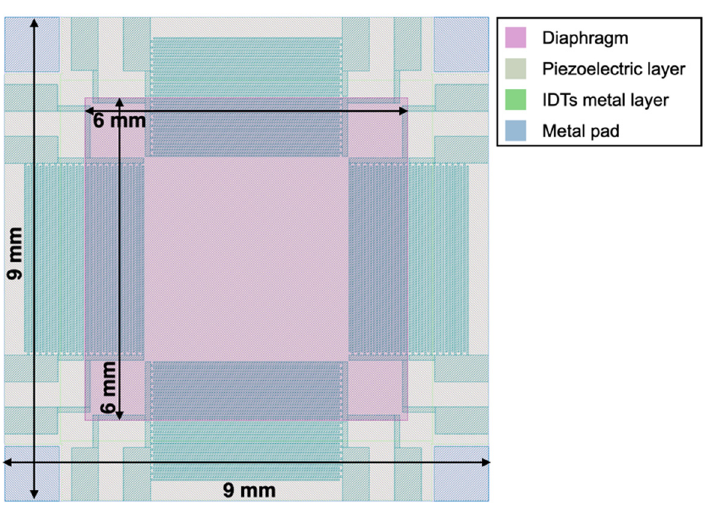
Figure 1. Top view image of the proposed piezoelectric micro electro-mechanical systems (MEMS) taken from the graphic design system (GDS) file.